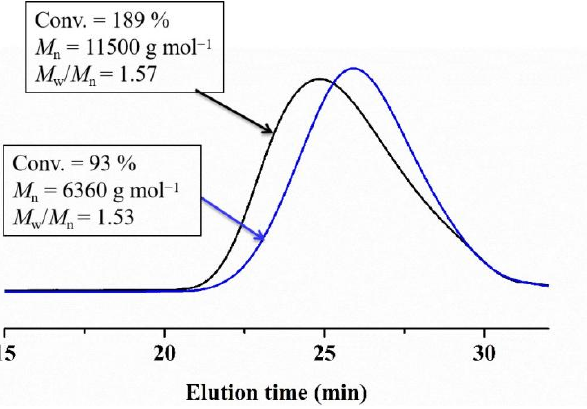
Figure 9. GPC traces of p ‐ MeSt obtained in a monomer addition experiment.